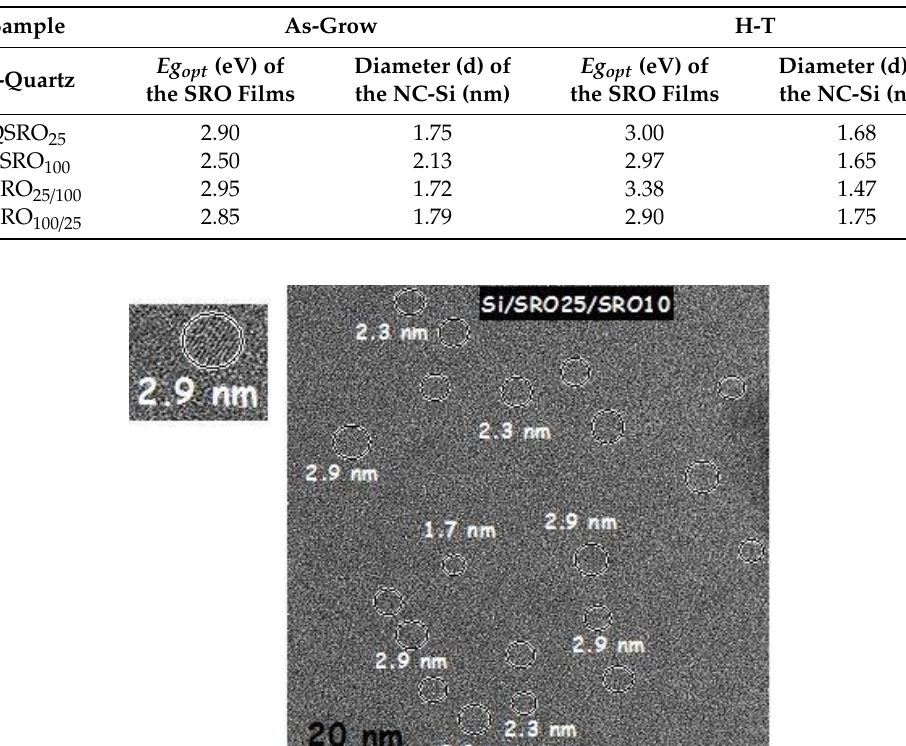
Figure 6. The transmittance of the SR0 25 , SRO 100 , SRO 25/100 , and SRO 100/25 films, ( a ) as-G and ( b ) with HT. Table 4. Theoretical values of the Eg opt and diameter of the Si-ncs calculated with the Tauc plot of the SRO films.